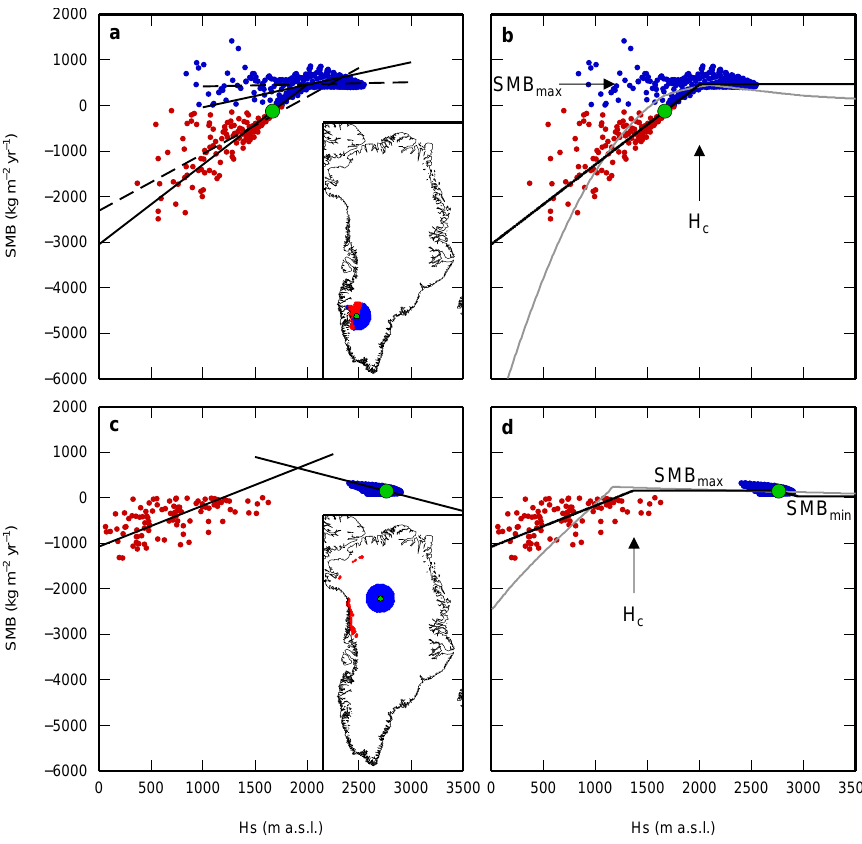
Fig. 3. (a) The effect of the choice between least square linear regression by minimizing vertical offsets (dashed lines) and minimizing perpendicular offsets (solid lines); (b) SMB gradients after maximizing the relation for the accumulation regime and forcing the relation for the ablation regime through the reference H s -SMB values; (c) a negative SMB gradient in the accumulation regime illustrates the necessity of introducing a minimum and maximum SMB value (d) to avoid ablation at high altitudes. Grey line represents SMB calculated by a PDD